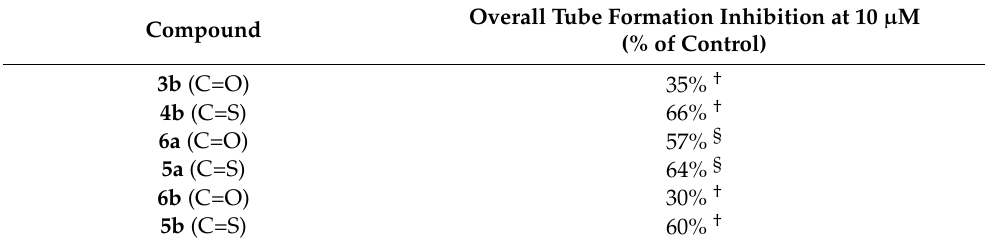
Table 1. Comparison of tube formation inhibition activities of 4-C=O and 4-C=S derivatives at 10 µ M.